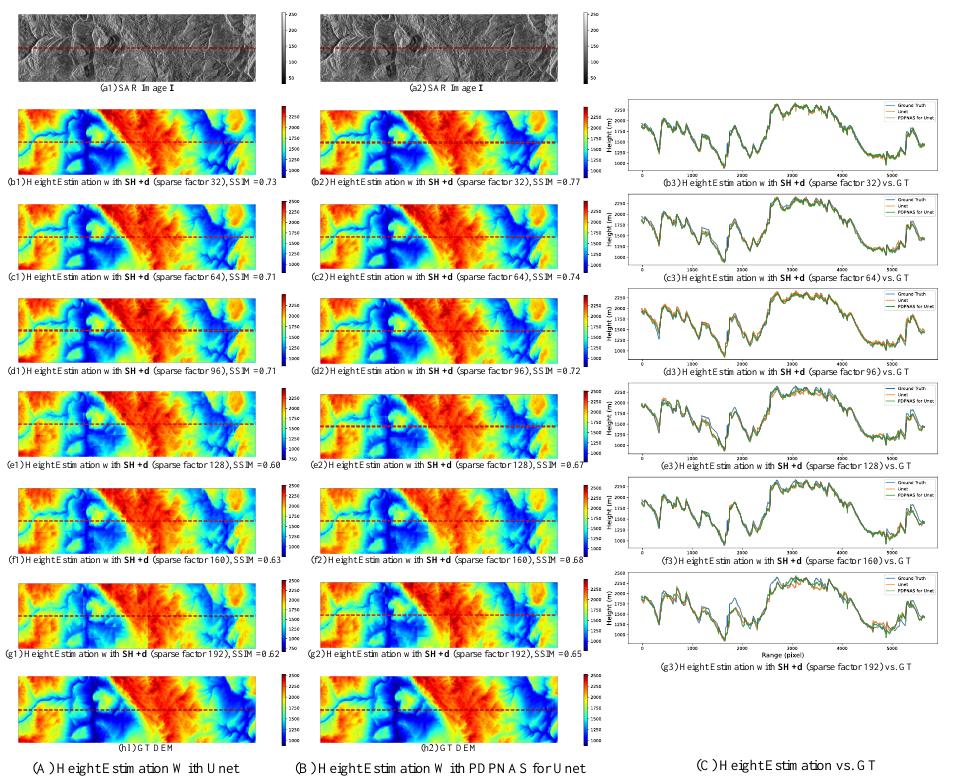
Figure 12. Comparison experimental results of different sparse height information as inputs with/without PDPNAS for Unet in Guiyang datasets. Different sparse height information was applied, and the downsampling factors are 32 × 32, 64 × 64, 96 × 96, 128 × 128, 160 × 160, and 192 × 192. Elevation lines along range directions with a fixed middle azimuth value marked by red dash lines in ( a1 – g1 ), ( a2 – g2 ) are plotted in ( b3 – g3 )